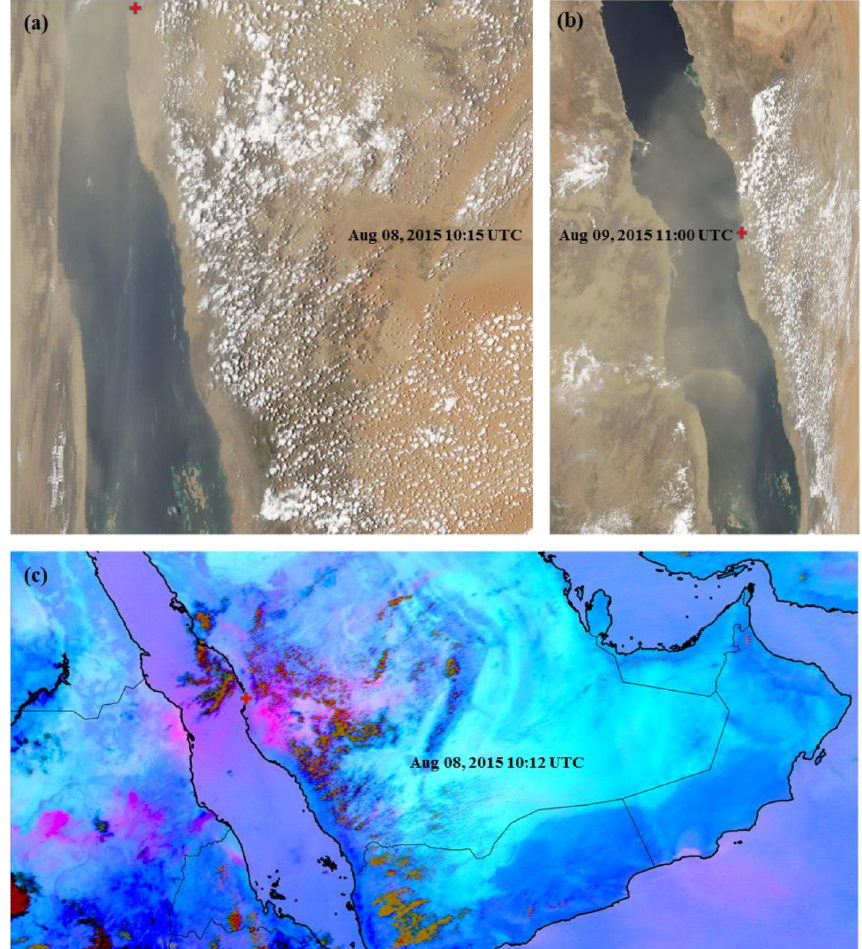
Figure 7. MODIS and SEVIRI images during a large-scale dust event. True color images from MODIS on (a) 8 August 2015, 10:15UTC, (b) 9 August 2015, 11:00UTC, and (c) Meteosat SEVIRI RGB dust composite for 8 August 2015, 10:12UTC. The KAUST site is marked by a red ( + )